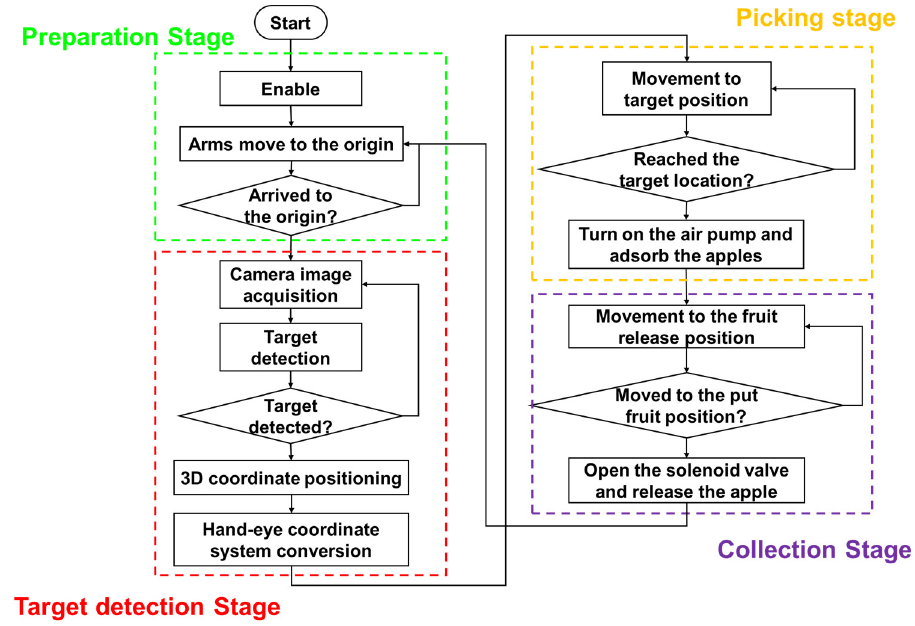
Figure 21. A flowchart of the harvesting robotic system.